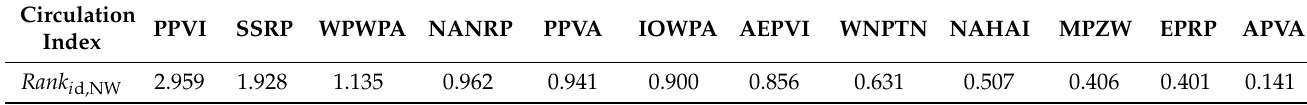
Table 4. The overall importance rank of 12 circulation indexes in northwestern